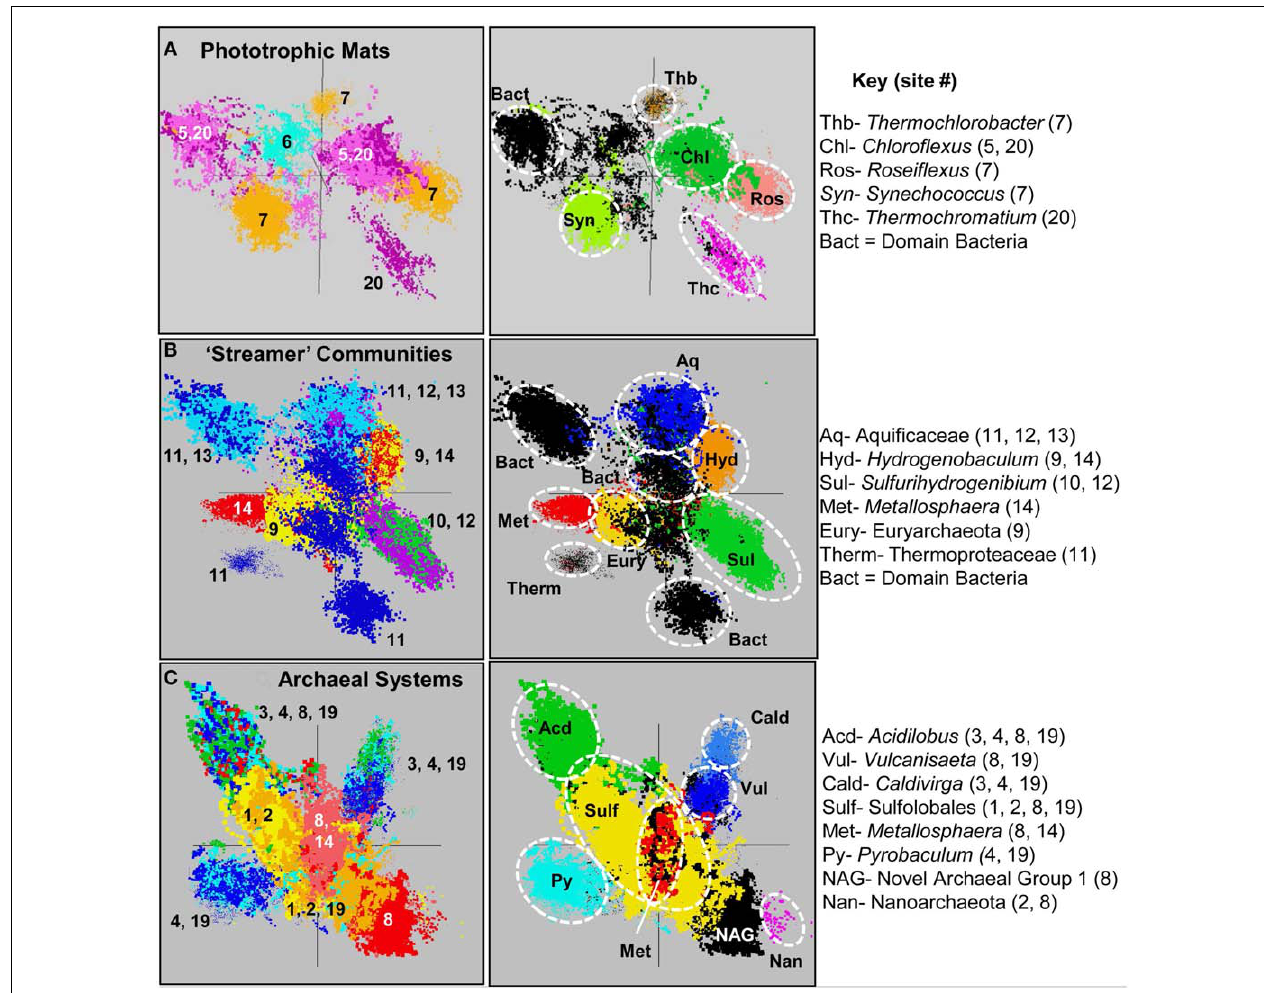
OSP_14 = red; MHS_10 = green; CS_12 = violet; OS_11 = dark-blue; BCH_13 = light-blue. Archaeal Systems : CH_1 = gold; NL_2 = yellow; MG_3 = green; CIS_19 = light-blue; JCHS_4 = dark-blue; OSP_8 = red; OSP_14 = pink). Sites OPP_17 andWS_18 not included. Right Column: Phylogenetic assignment of sequence clusters (identical PCA orientation) based on comparative sequence analysis of all contigs to reference genomes (APIS, Badger et al.,